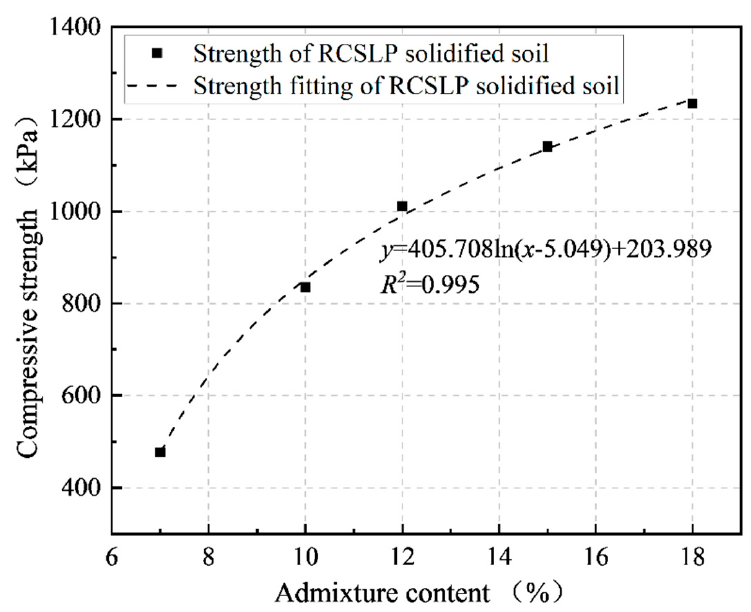
Figure 8. Compressive strength variation of the solidified soil with additive content.